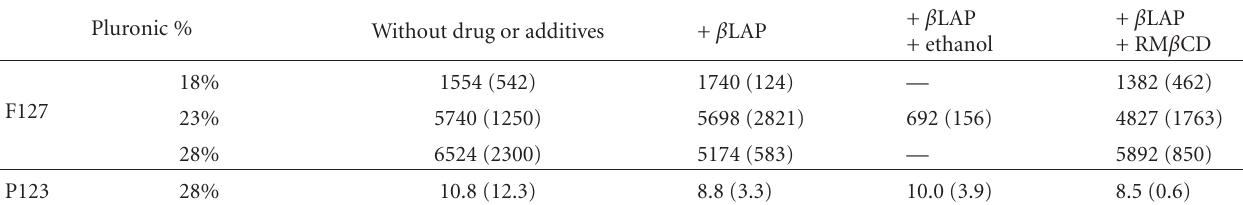
Table 2: Gel strength (N · m − 2 ) of the systems at 37 ◦ C: mean values and, in parenthesis, the standard deviations. Pluronic